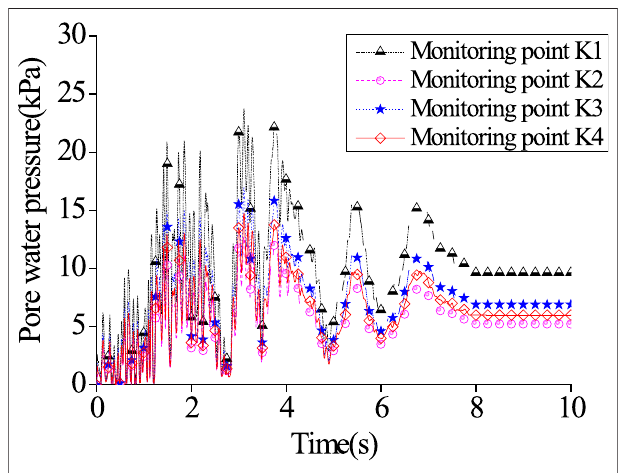
FIGURE15| Cumulative developmentofdynamicpore waterpressures in the slope.